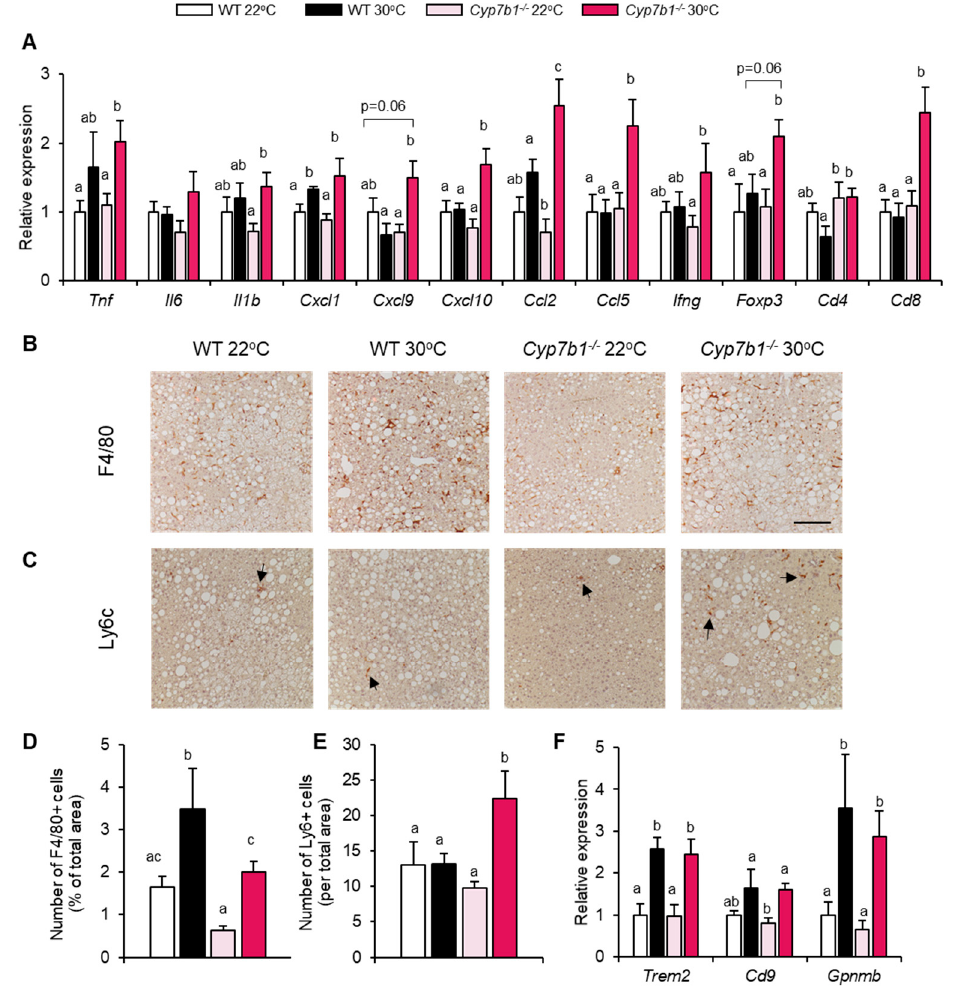
Figure 6. CYP7B1-deficiency leads to increased liver inflammation at thermoneutral housing conditions. Cyp7b1 − / − and WT littermates were housed at 22 °C or 30 °C and fed a CD-HFD for 8 months. ( A ) Relative hepatic expression of inflammation-related and T-cell related genes (n = 8). ( B , C ) Representative images of ( B ) F4/80+ cells and ( C ) Ly6c+ cells (scale bar 100 µm). ( D , E ) Quantifications of ( D ) F4/80+ and ( E ) Ly6c+ images shown in B and C, respectively (number of mice: WT 22 °C: n= 11; WT 30 °C: n = 9; Cyp7b1 − / − 22 °C: n = 16; Cyp7b1 − / − 30 °C: n = 13). ( F ) Relative hepatic gene expression of Kupffer cell-related markers (n = 8). Data are shown as mean values ± SEM. Different letters indicate significant differences between groups ( p < 0.05) determined by two-way ANOVA.